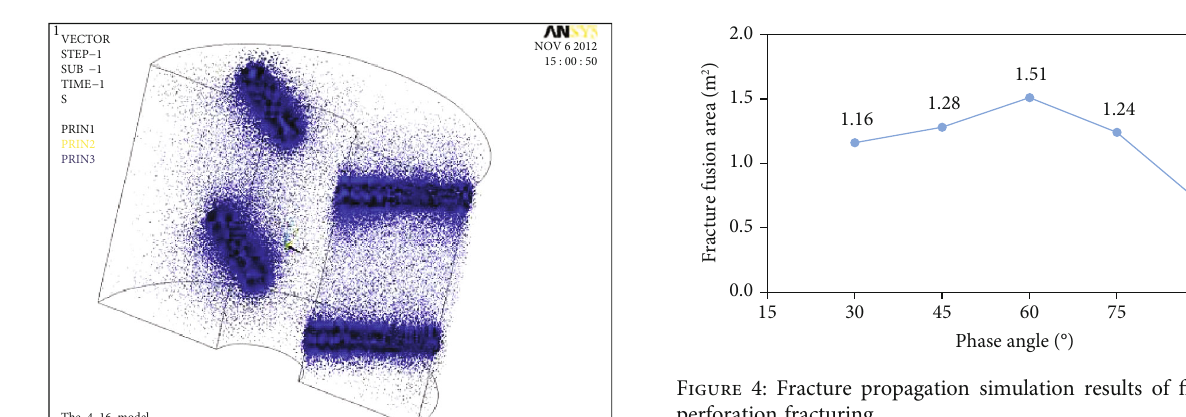
Figure 1: Fracture simulation results of conventional fracturing in well X18-06.